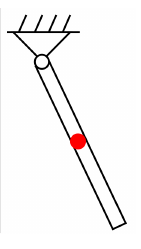
Figure 3. Planar